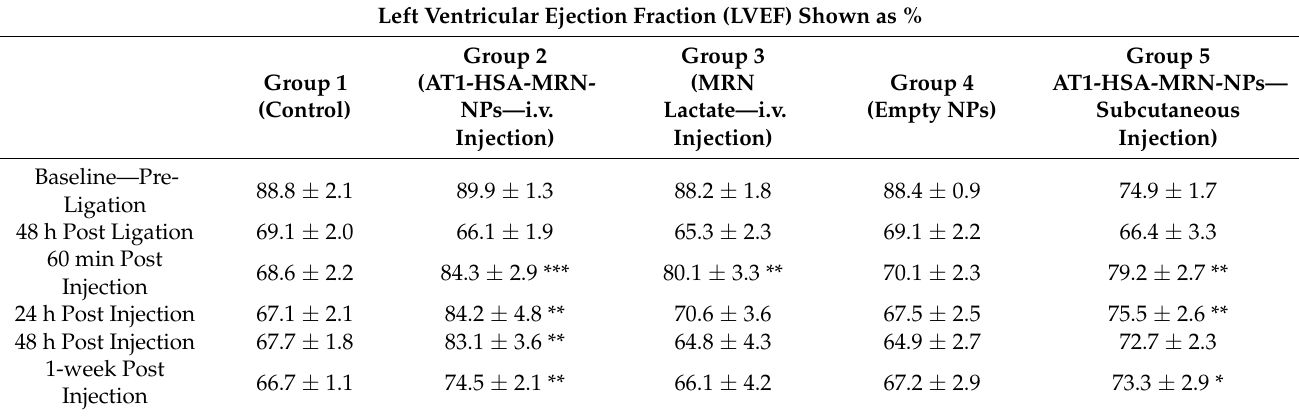
Figure 7. Percentage LVEF measurements for Groups 1, 2, 3, 4, and 5 at baseline, 48 h post ligation, 60 min, 24 h, 48 h, and 1-week post injections. The graph shows a representative result of mean ± SD ( n = 5). *** p < 0.001, ** p < 0.01 and * p < 0.05 were considered significant based on Tukey’s post hoc analysis. Table 4. Percentage LVEF measurements for Groups 1, 2, 3, 4, and 5 at various